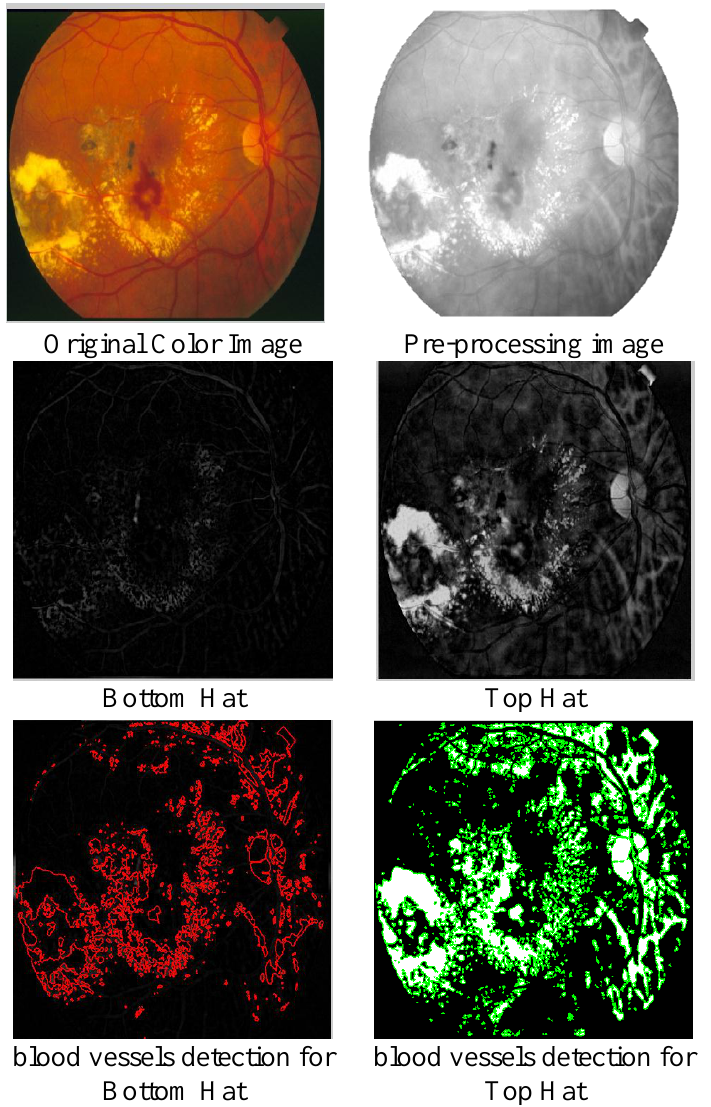
Fig.9: Retinal fundus images which contain blood vessels (abnormalities) that can be detected using simple morphological operations using top, bottom hat